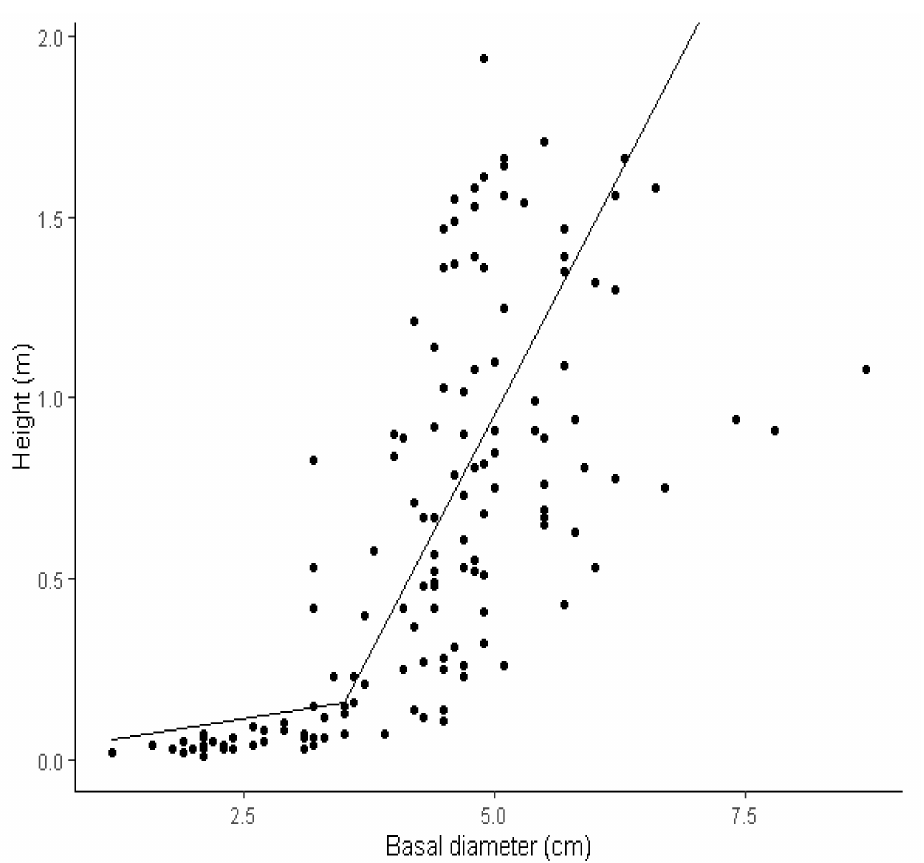
Figure A1. Longleaf pine seedling basal diameter to height relation with segmented regression